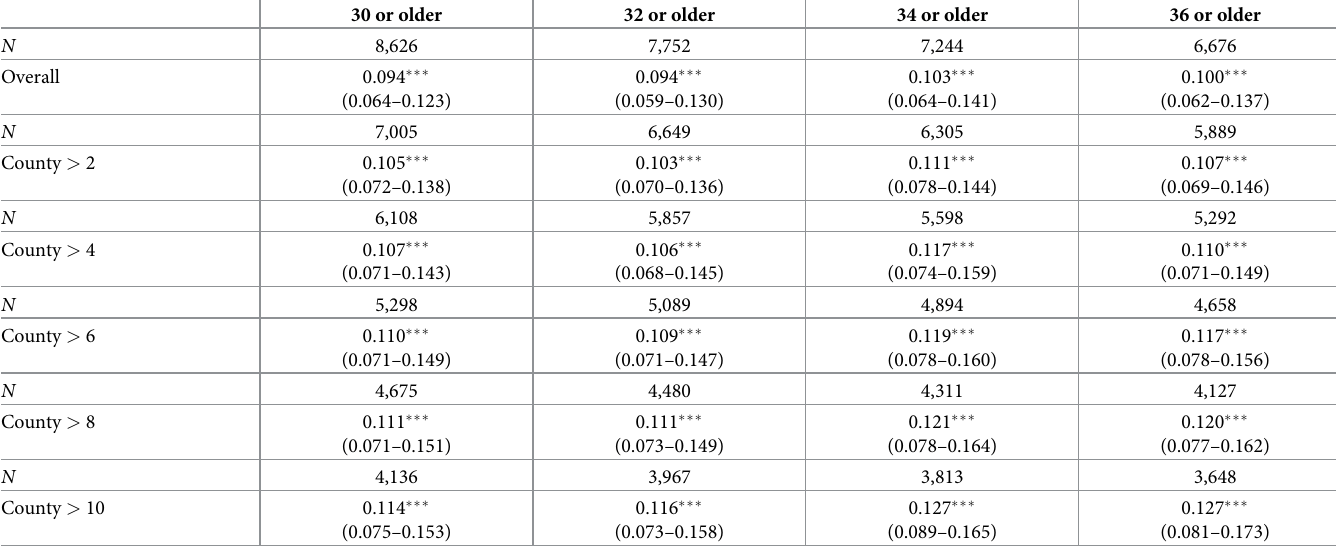
Table 4. The “effect” of neighborhood on education level: Estimates of the percentage of the variation in adult educational attainment attributable to county of